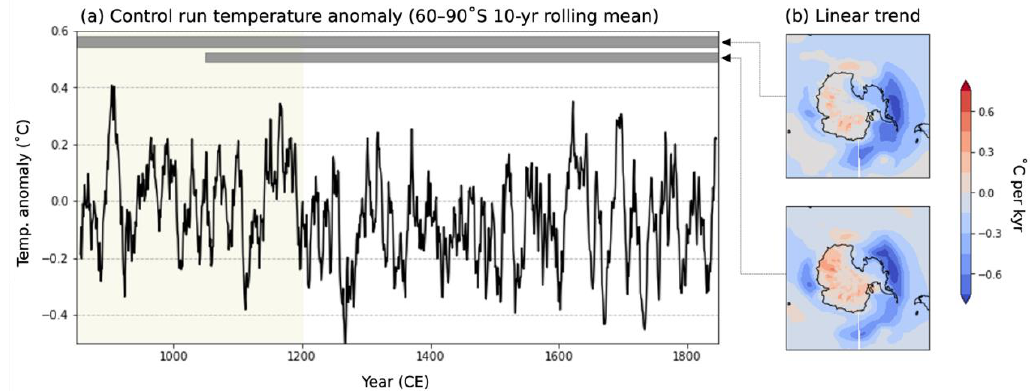
Figure 2. Antarctic annual surface temperature anomalies (°C) in the 850 CE control simulation; ( a ) average temperature between 60° and 90° south relative to the base period of 850 – 1200 CE (highlighted in beige). A 10-year rolling mean was applied; ( b ) linear trend (°C/kyr years) for the full control simulation (850 – 1850 CE, top), and the last 800 years (1050 – 1850 CE, bottom).